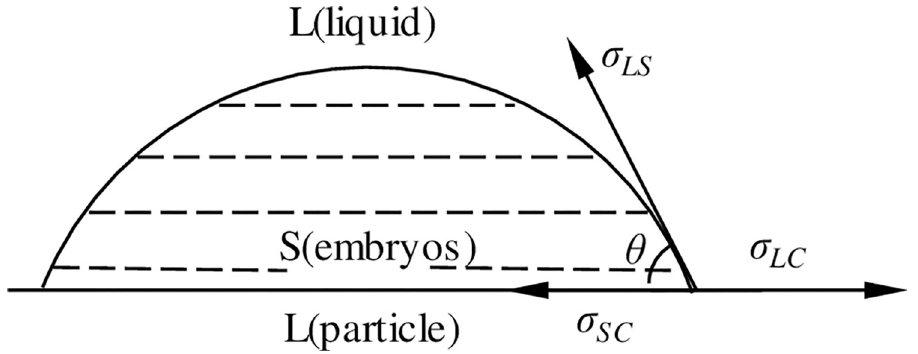
Fig 11. Scheme of heterogeneous